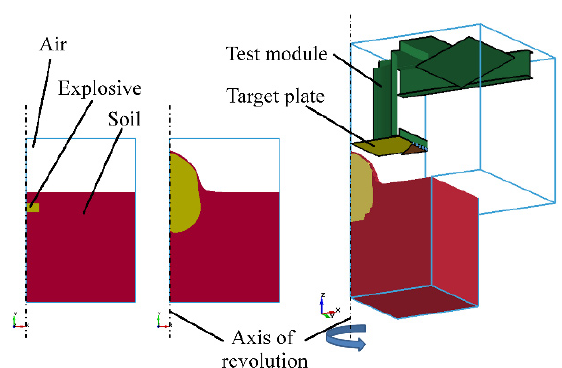
Figure 11. To the left, the material contours in the 2D model are shown prior to detonation. In the middle, at the time when the shock wave reaches the upper boundary of the 2D model. To the right, the 3D model is shown after mapping from the last 2D state.